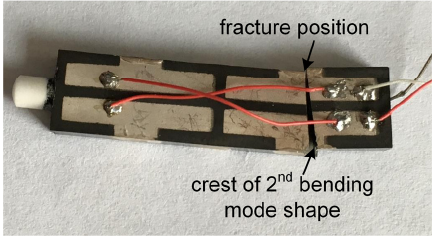
Figure 8. Fracture form of the piezo ‐ vibrator.